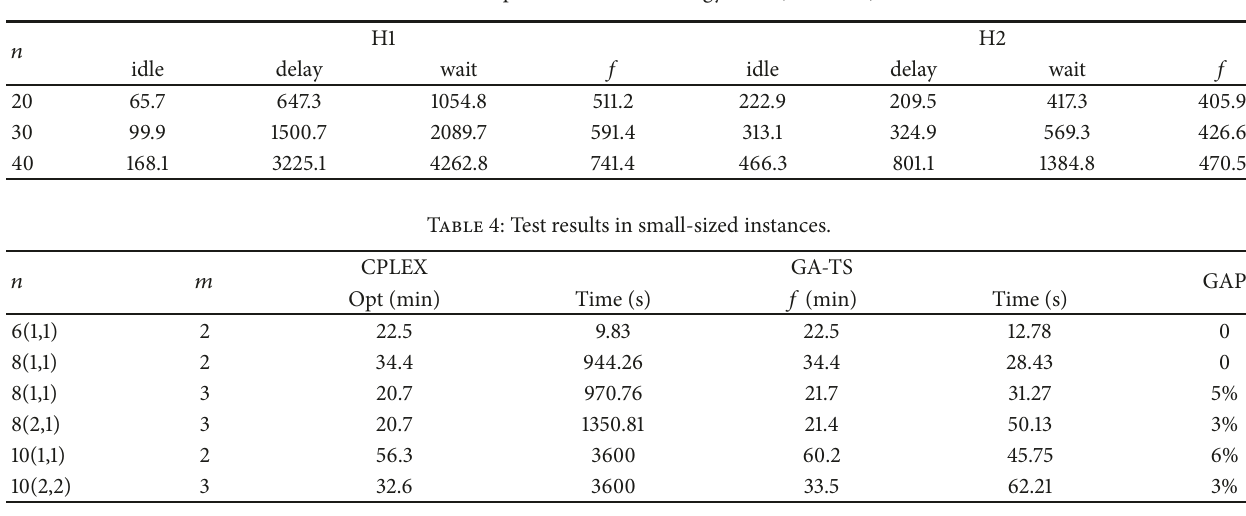
Table 3: Comparison result of strategy rules (unit: min).